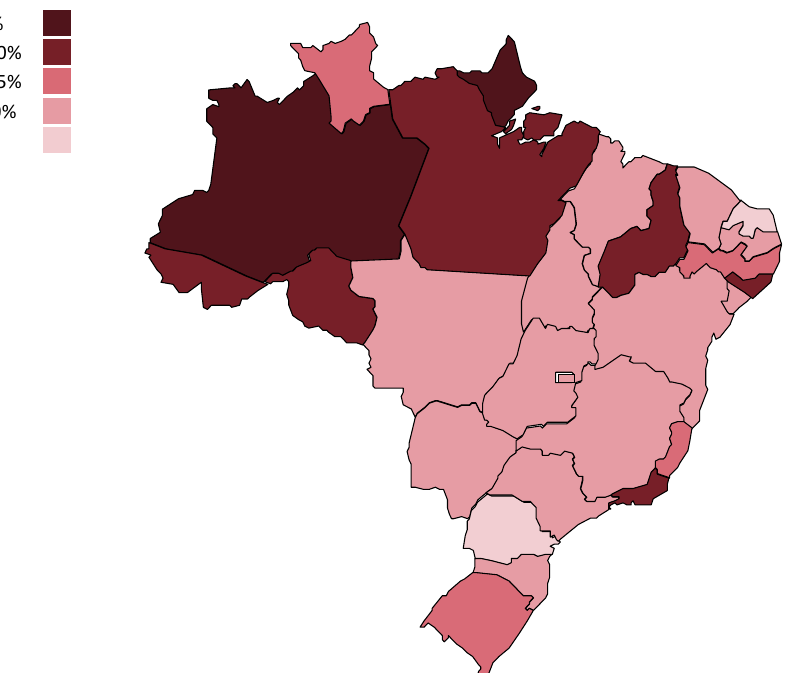
Figure 8. Spatial distribution of the PNTLs among the Brazilian states in 2016 [9].